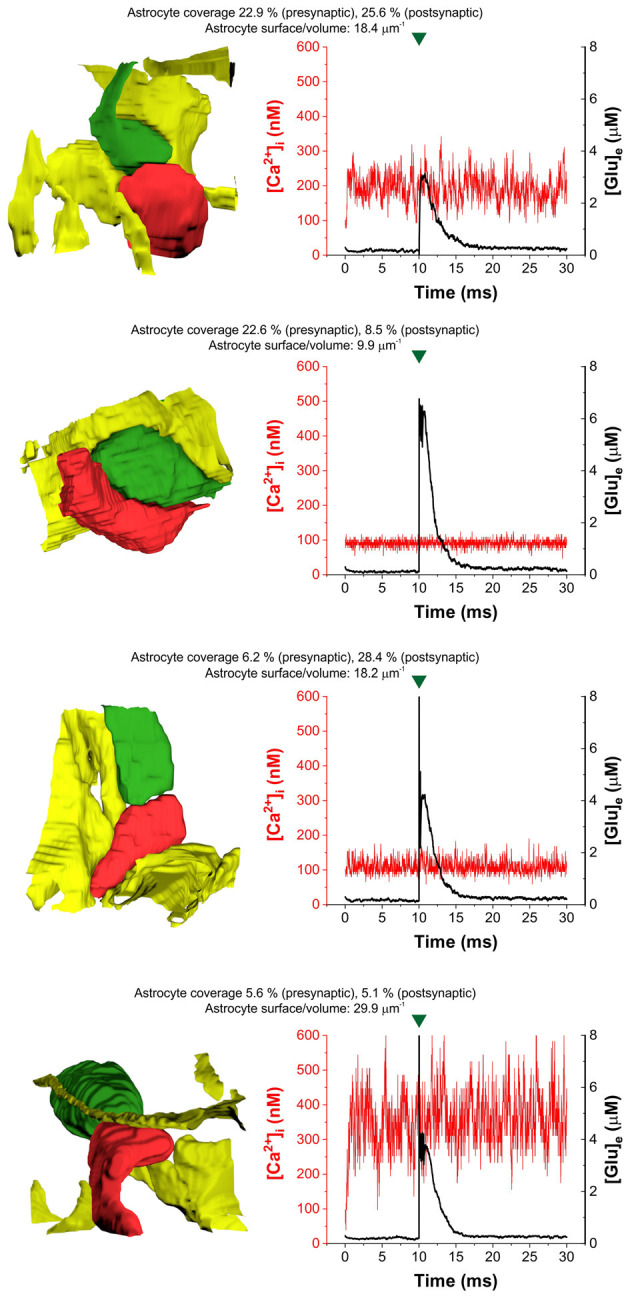
Heterogeneity of astrocytic intracellular Ca2+ oscillations ([Ca2+]i) during the control period (1–10 ms) and following glutamate release (10–30 ms) in four selected real tripartite synapses showing different levels of astrocytic coverage and astrocyte SVR. The dynamics of astrocytic Ca2+ concentration is shown in red, extracellular [Glu] ([Glu]e) is shown in the black trace. Astrocytes are colored yellow, presynaptic terminals are green and postsynaptic spines are red in images showing real 3D geometry of each synapse. Green marks indicate release events.